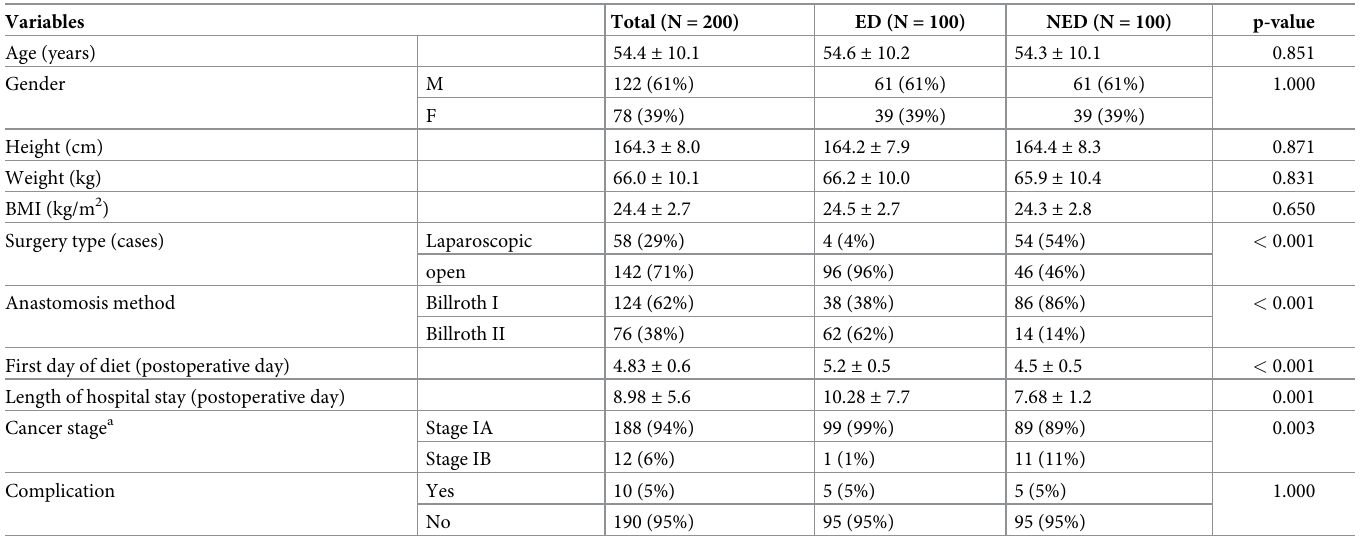
Table 1. Clinicopathological characteristics of the patients.